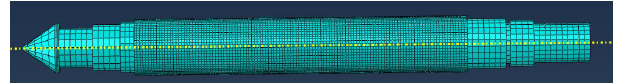
Figure 16. Meshing of the main structure and epoxy resin